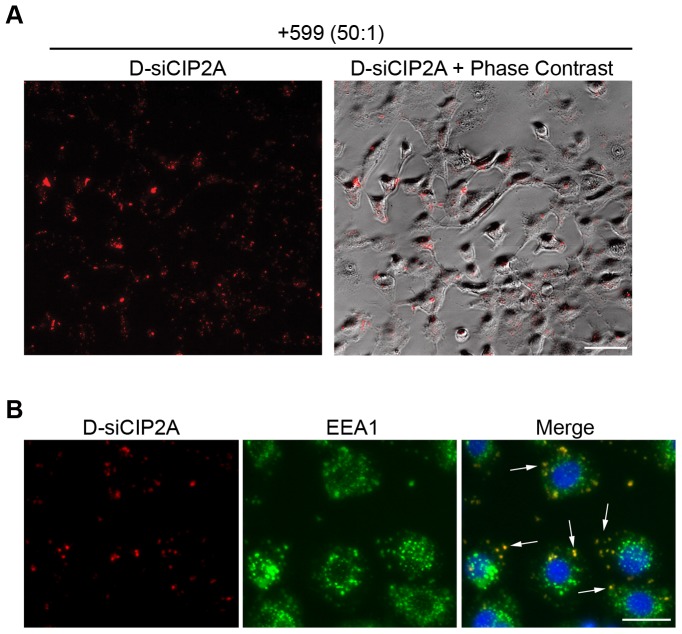
The 599 peptide mediates delivery of siRNAs into cells via endocytosis.(A) Fluorescence microscopy analysis and overlay of a phase contrast image of live CAL 27 oral cancer cells incubated for 2 hours with DY547-conjugated siRNA targeting CIP2A (D-siCIP2A; red) complexed with the 599 peptide at a 50∶1 peptide-to-siRNA molar ratio. Scale bar: 50 µm. (B) Indirect immunofluorescence microscopy analysis of CAL 27 oral cancer cells incubated for 2 hours with D-siCIP2A (red) complexed with the 599 peptide at a 50∶1 peptide-to-siRNA molar ratio. Endosomes (green) were stained using a rabbit monoclonal anti-EEA1 antibody. Nuclei (blue) were counterstained with DAPI. The co-localization of D-siCIP2A with endosomes (yellow) is observed in the merged panel and is emphasized by arrows. Scale bar: 25 µm.